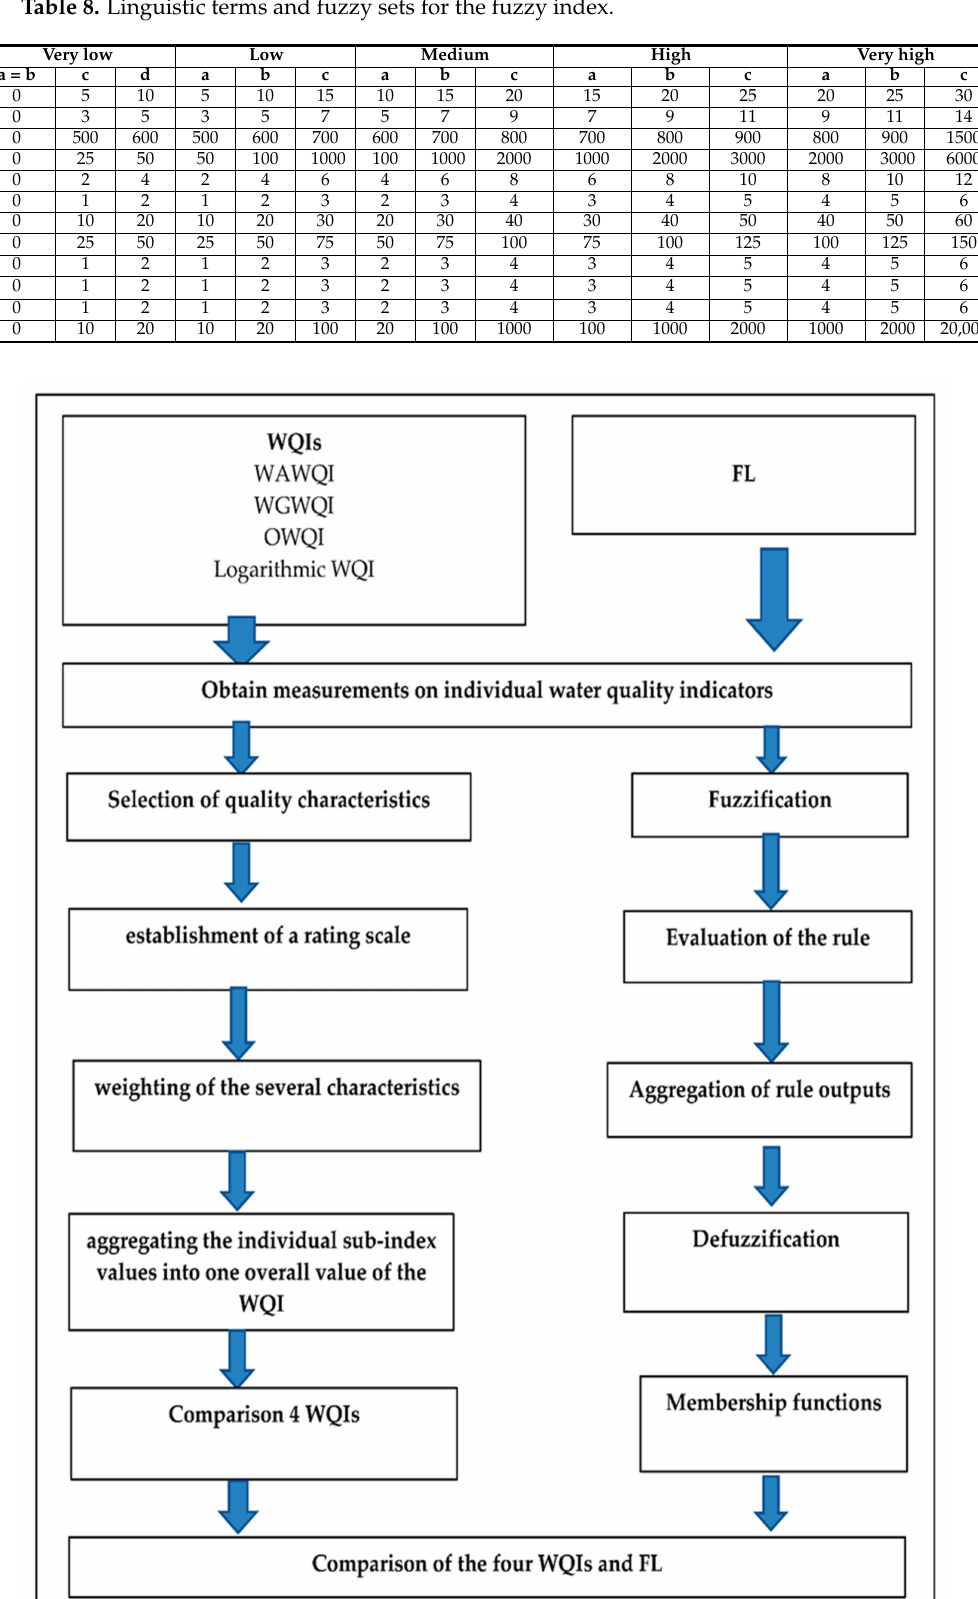
Figure 5. Flowchart illustrating the methodology and steps of WQIs and